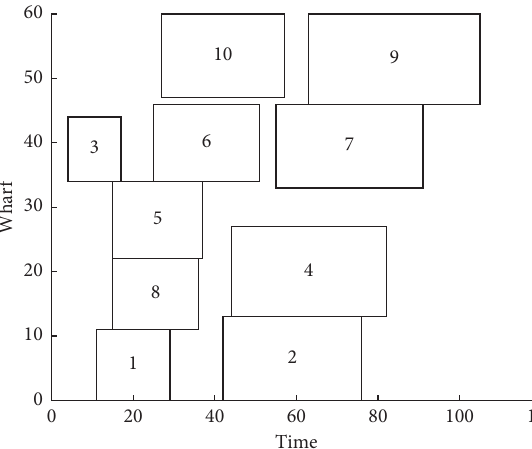
Figure 4: The robust berth plan of the example instance.